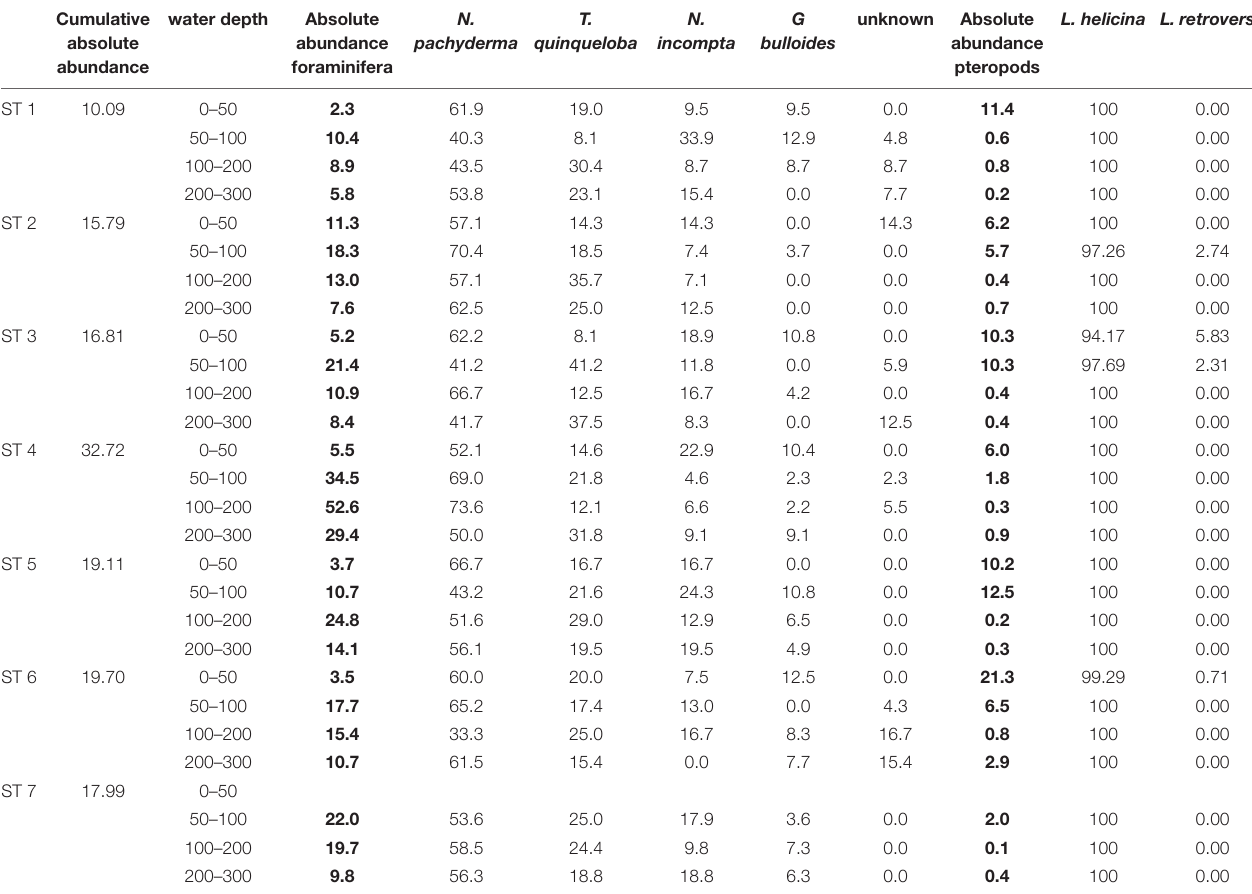
TABLE 4 | Cumulative and absolute abundance (ind m − 3 ) and relative abundance of the main species. Cumulative water depth Absolute absolute abundance